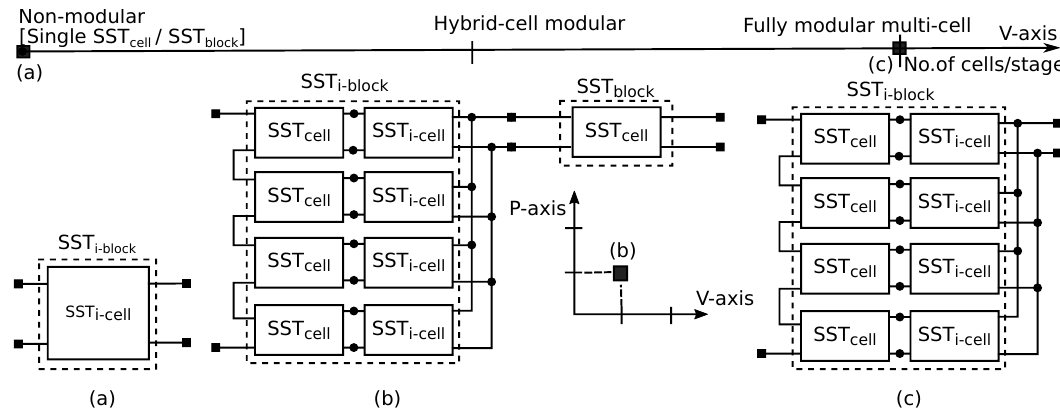
Figure 17. Modularization based on voltage/current levels: ( a ) non-modular SSTs, ( b ) hybrid-cell SPDS SSTs, and ( c ) fully modular multi-cell